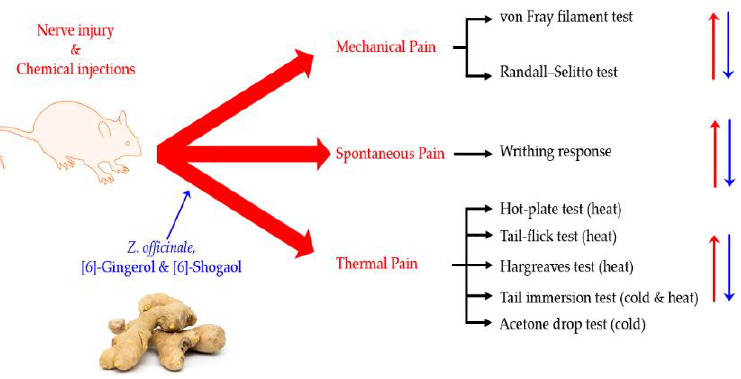
Figure 1. Analgesic effects of Z. officinale , [6]-gingerol and [6]-shogaol in mechanical, spontaneous, and thermal pain induced by nerve injury or chemical injection, and a summarization of behavior tests used in the experiment. The pain is induced by a nerve or chemical injection (Red) and alleviated by Z. officinale and its sub-components (Blue). Abbreviations: Z. officinale ( Zingiber officinale Ros- coe).